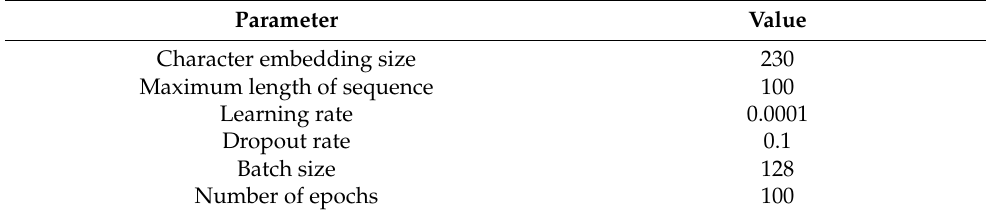
Table 3. Experimental